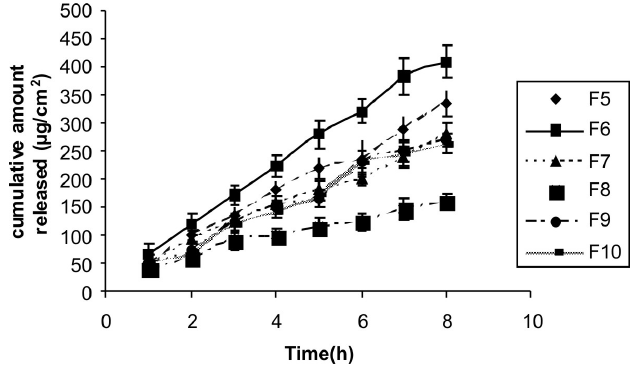
FIGURE 1 - Release profiles of glipizide from different matrix patches.